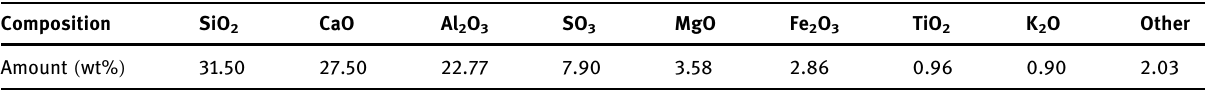
Table 1: Composition of the protective layer